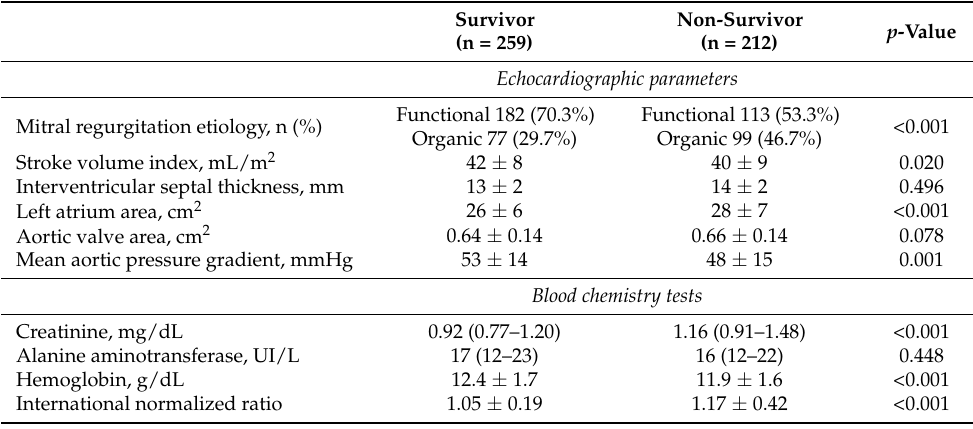
Table 3. Prediction selected for 5-year mortality prediction after transcatheter aortic valve implanta- tion